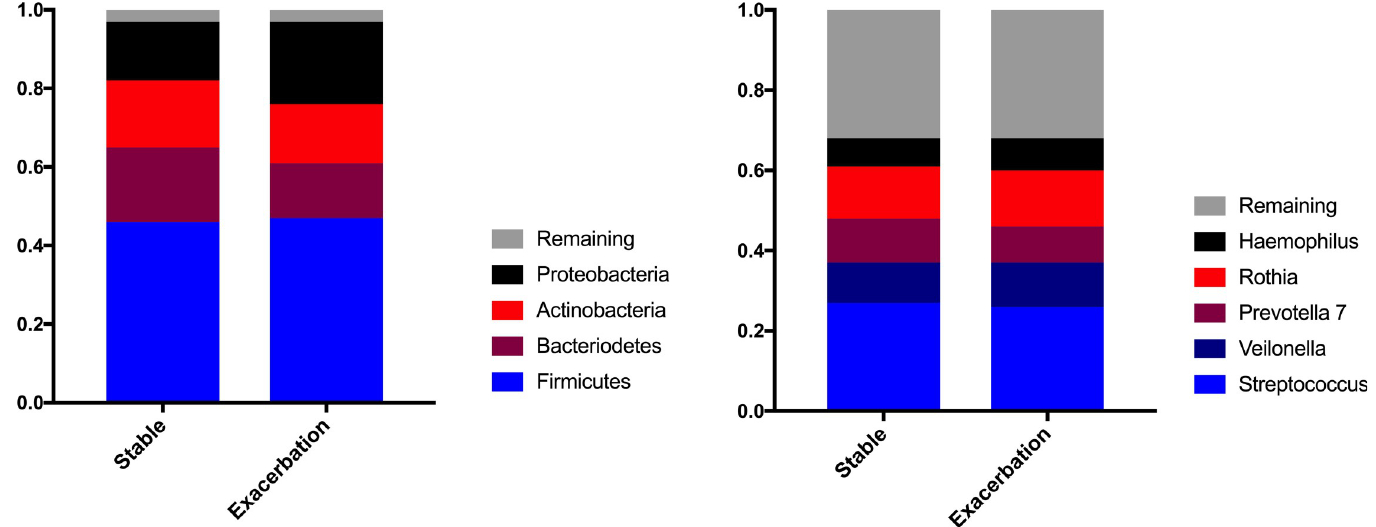
Fig 3. The four most abundant phylae and the five most abundant genera found in induced sputum samples from COPD patients during the stable state, and during exacerbations.